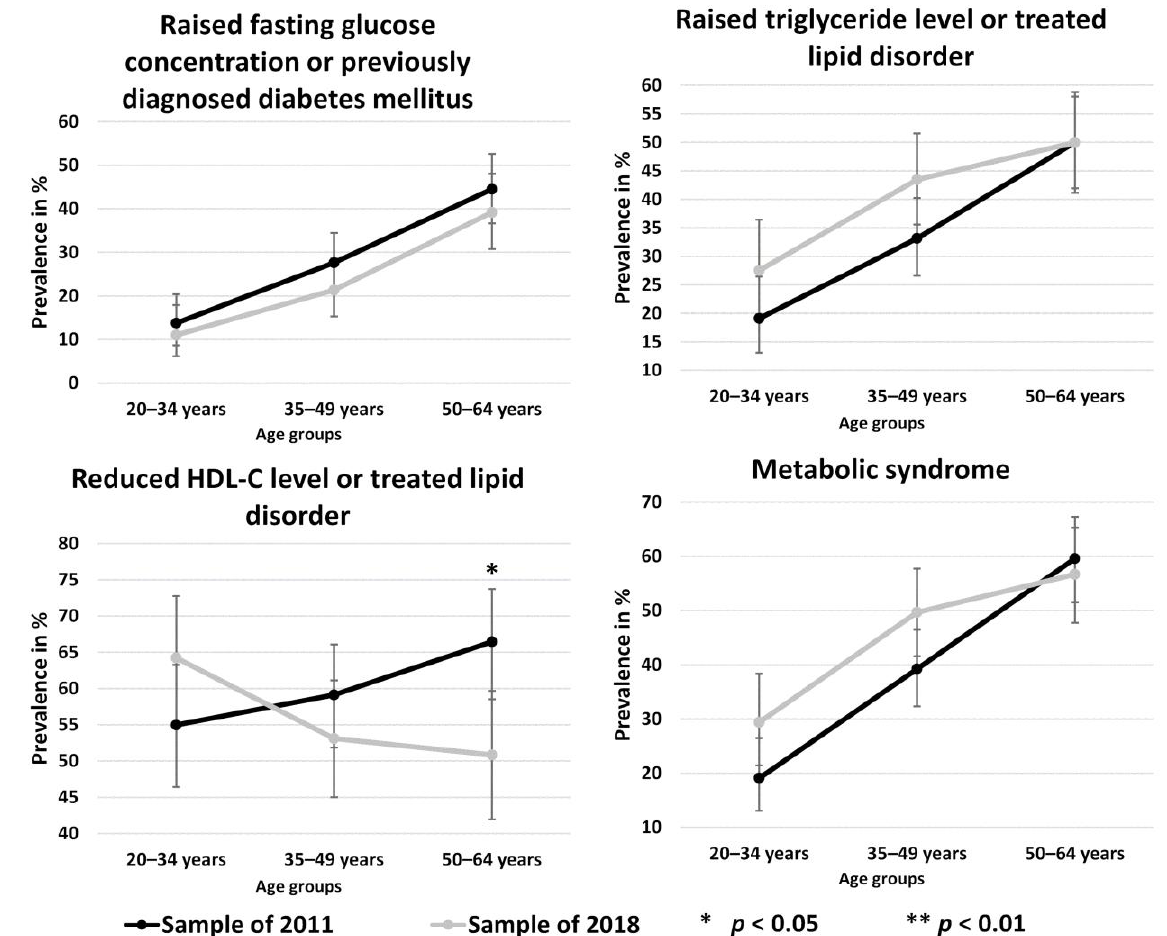
Figure 2. Changes in the prevalence of metabolic syndrome and its components by age group in the Northeast Hungarian Roma population from 2011 to 2018.